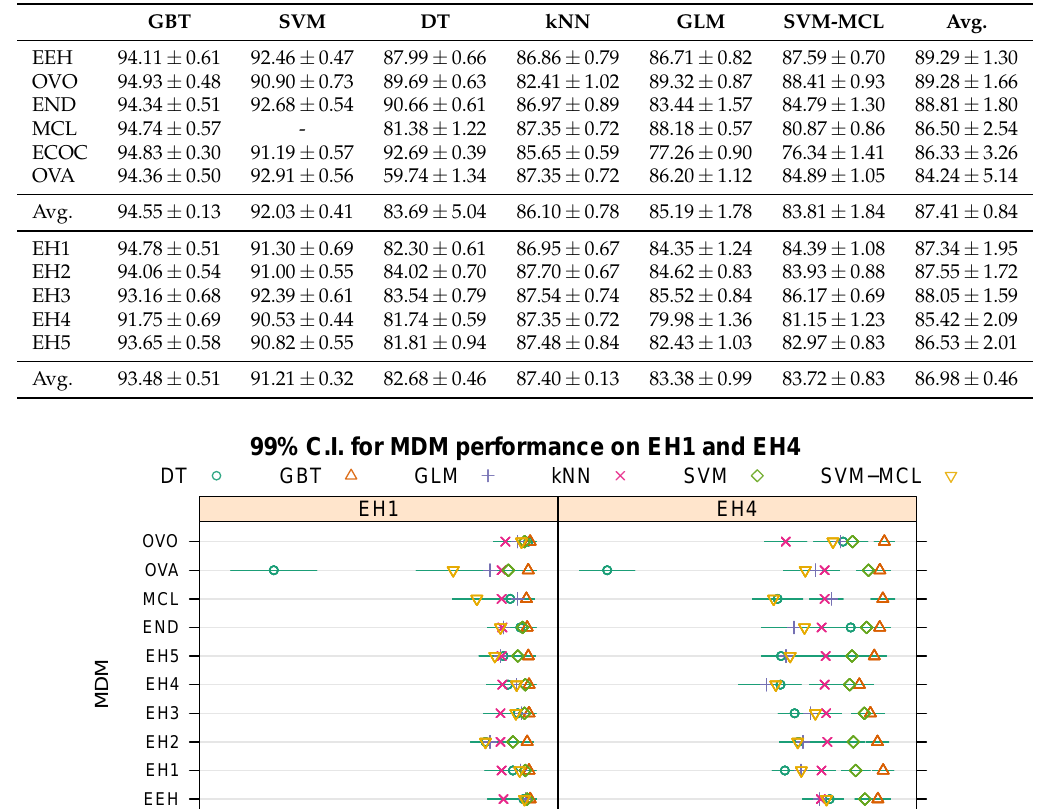
Table 4. Mean κ % (± SE) for the topmost dichotomy of EH4 (Possible Emergency vs. non-Emergency). The first six multi-class decomposition methods are given in order of decreasing average score, the five expert hierarchies in alphabetical order.